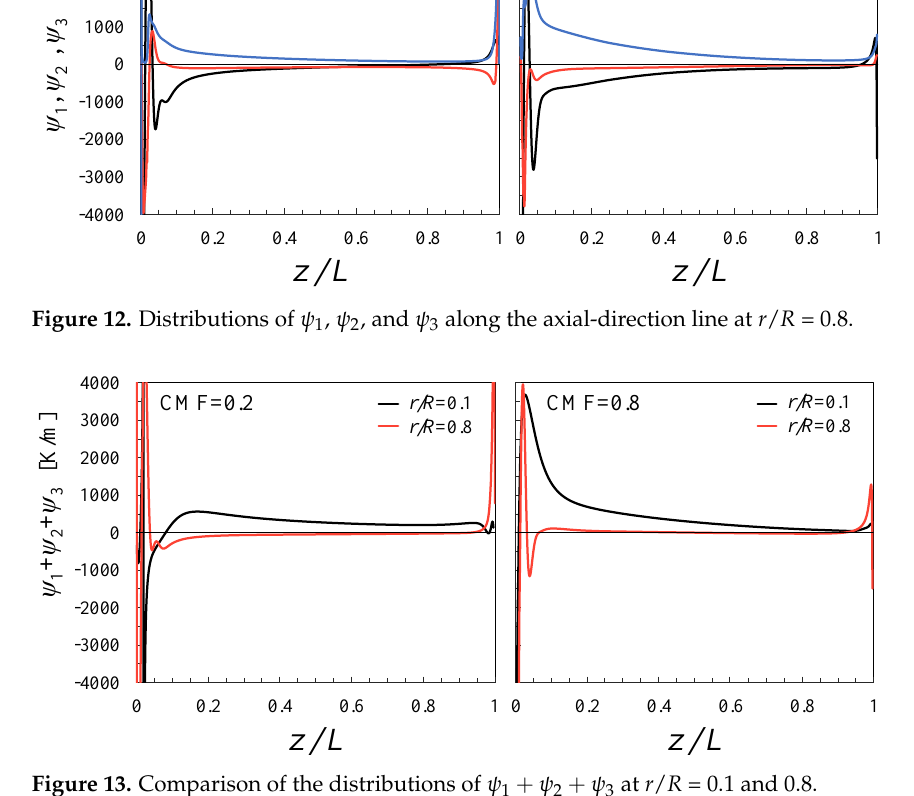
Figure 11. Distributions of ψ 1 , ψ 2 , and ψ 3 along the axial-direction line at r / R = 0.1. Figure 12 plots the distributions of ψ 1 , ψ 2 , and ψ 3 along the horizontal lines at r / R = 0.8 (periphery region). The viscous dissipation effect ( ψ 2 ) is seen to contribute the most to the temperature separation in the peripheral region. However, that effect is expected to be reduced by the other effects. Figure 13 compares the distributions of ψ 1 + ψ 2 + ψ 3 at r / R = 0.1 and 0.8. For both cmf = 0.2 and cmf = 0.8, the magnitudes of ψ 1 + ψ 2 + ψ 3 at r / R = 0.1 are considerably greater than those at r / R = 0.8. Consequently, the increase in the hot exit temperature results from the axial pressure gradient in the core region; the higher the cold mass fraction, the larger the axial pressure gradient is. Thus, the hot exit temperature increases with the cold mass fraction. CMF=0.2 CMF=0.8